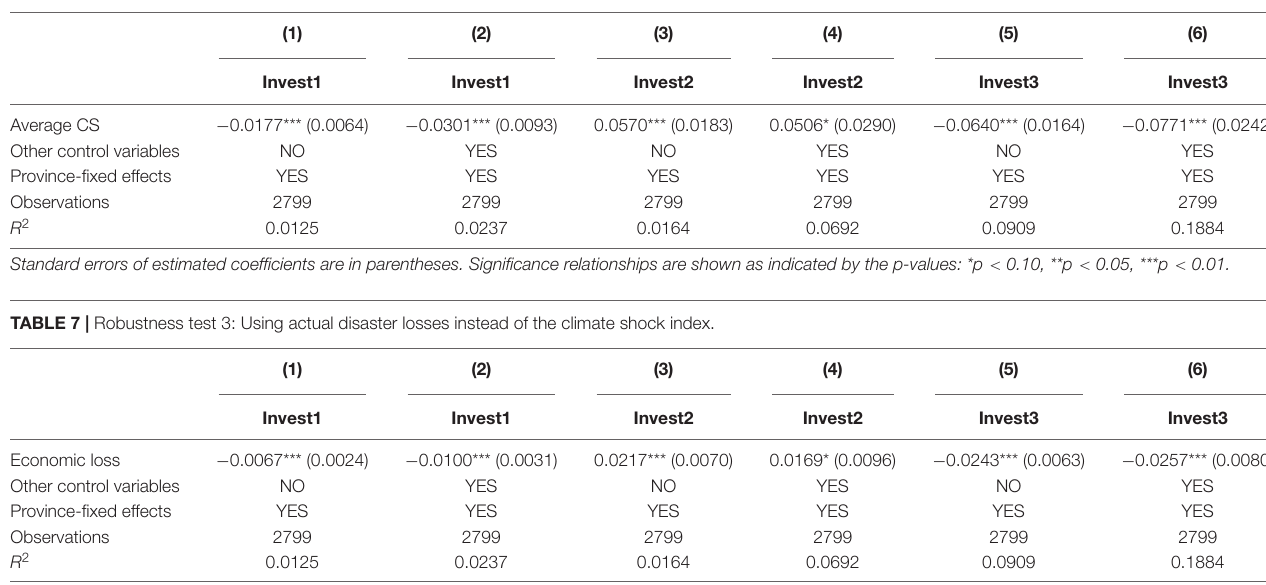
TABLE 6 | Robustness test II: Replace the core explanatory variable with the average value of the climate shock index in the past 3 years.